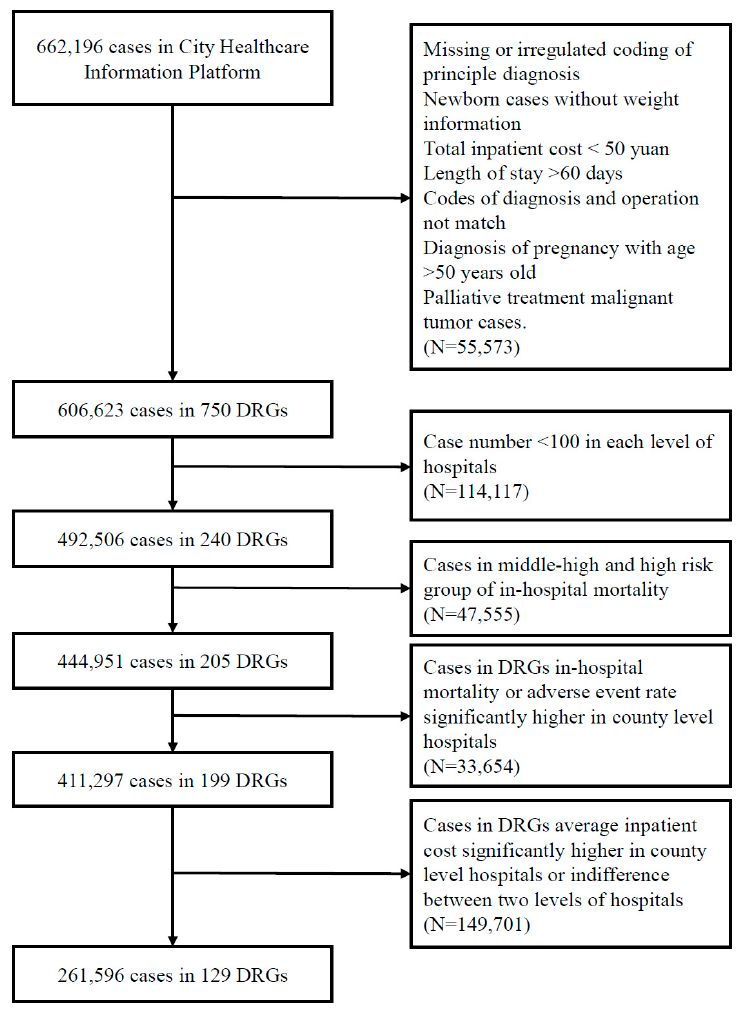
Figure 1. Flowchart for case selection process. DRGs: diagnosis-related groups.